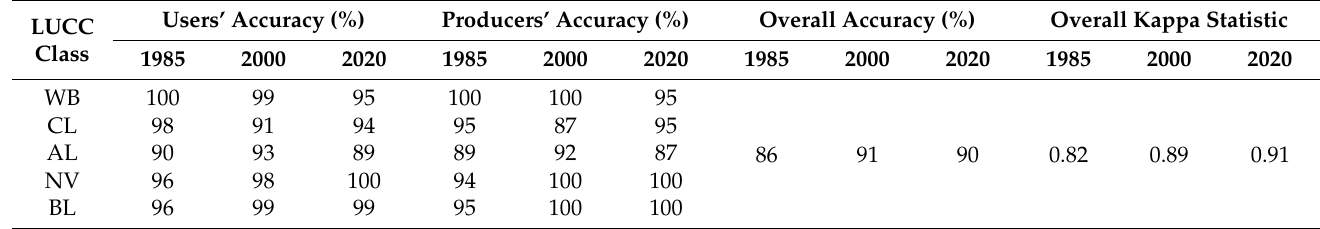
Table 2. Results of LUCC classification accuracy from 1985 to